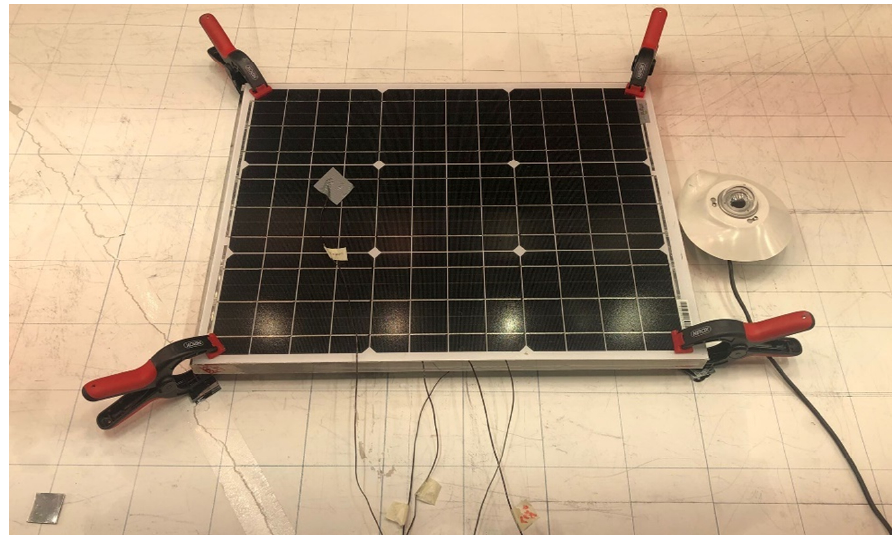
Figure 4. Experimental indoor setup.